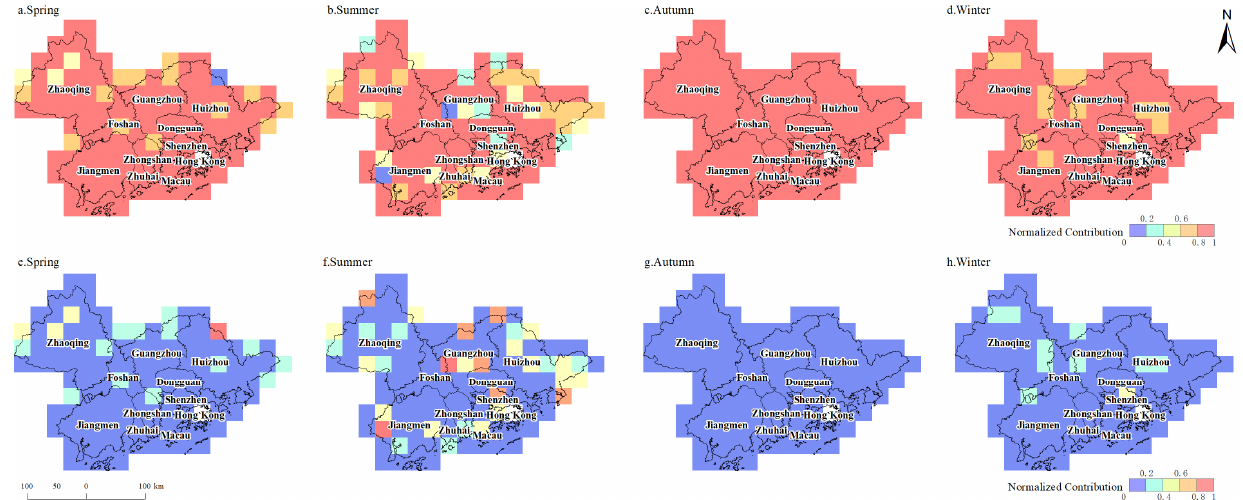
Figure 5. Distribution of the normalized contribution of seasonal meteorology and emission in the GBA. ( a – d ) for normalized meteorological contributions and ( e – h ) for normalized emission contributions).